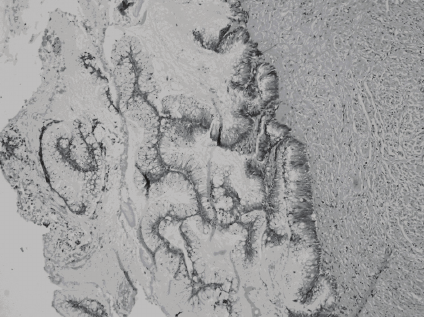
Figure 3: Histopathological microphotograph of the accumulated mucin in the appendix